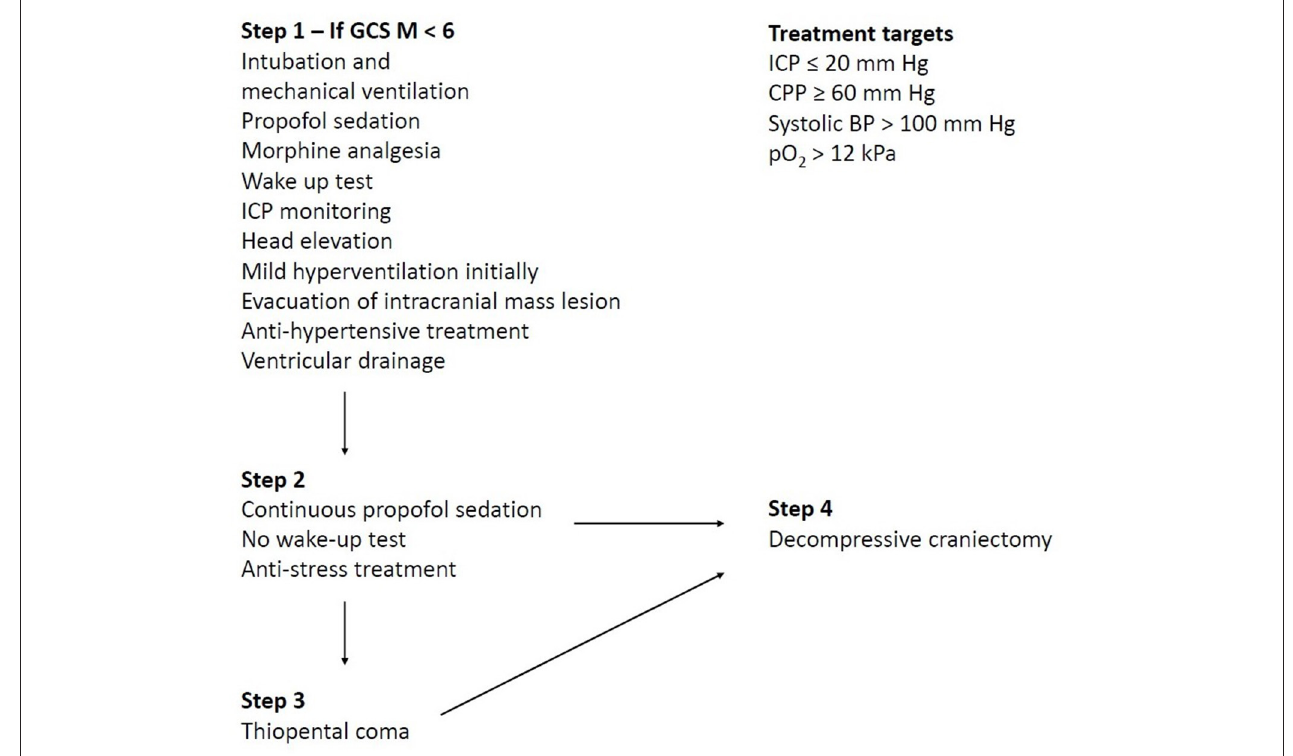
FIGURE 2 | The Uppsala standardized traumatic brain injury (TBI) management protocol as an example of a local escalated intracranial pressure (ICP)-oriented management protocol with a focus on avoiding secondary insults. The figure demonstrates an example of a local ICP-oriented management protocol (2). The therapeutic intensity is gradually increased by starting with ICP-lowering treatments that carry a lower risk of complications and escalating to treatments with greater risks if the ICP target cannot otherwise be controlled. Decompressive craniectomy may be performed both on a primary indication (first surgical procedure, i.e., the fourth step is used as the first step) in the case of severe brain edema in the early course, but chiefly on a secondary indication (when all other treatments are